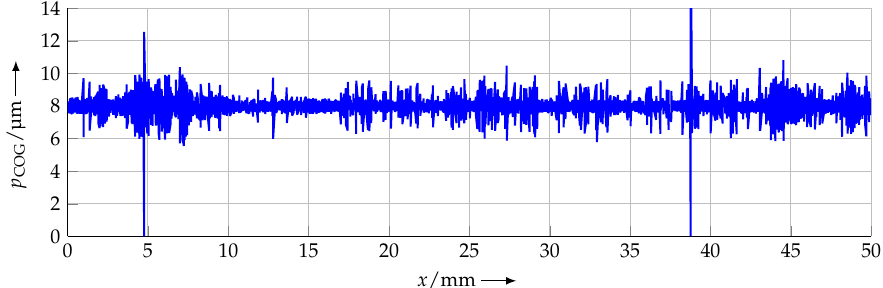
Figure 10. Local pitch of the measured grating. As the COG method allows us to calculate the pitch for every period of the sample, local deviations from the nominal pitch p n can be